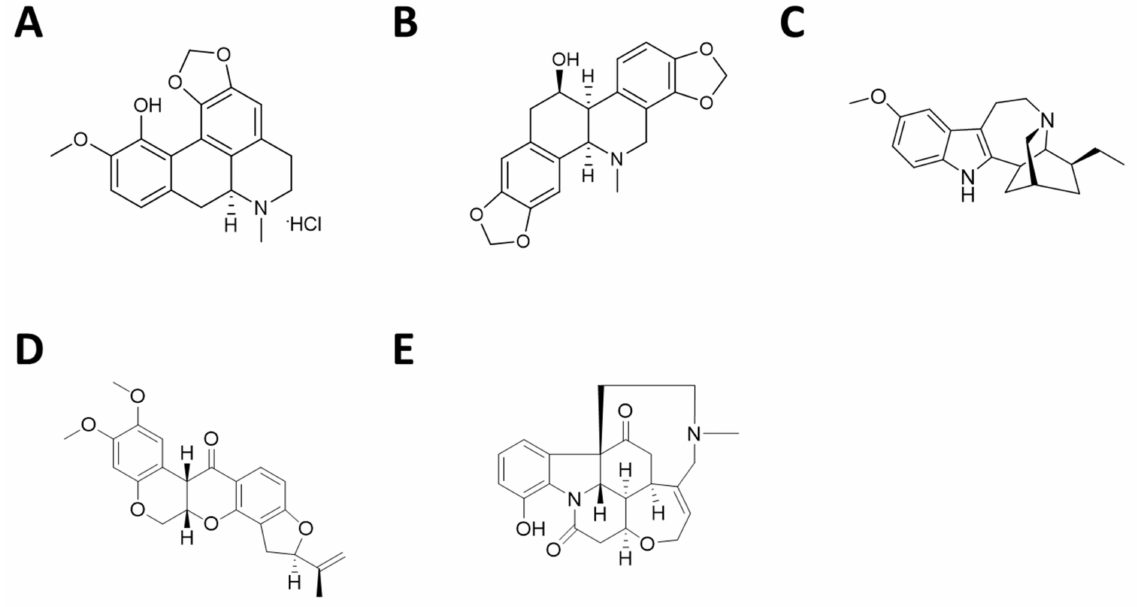
Figure 1. Chemical structures of ( A ) Bulbocapnine, ( B ) Chelidonine, ( C ) Ibogaine, ( D ) Rotenone and ( E )